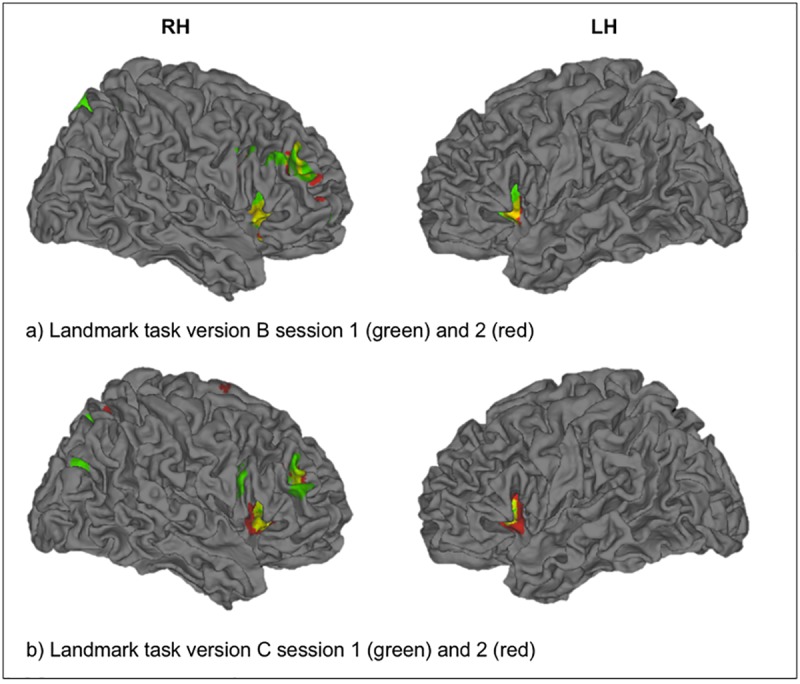
Group activation patterns evoked by the Landmark task version B and C.Activation of the first (green) and second session (red) are plotted together (p < 0.001 uncorrected, k = 20) for version B (top) and version C (bottom), respectively. Yellow colored regions indicate voxels that were active in both sessions. RH = right hemisphere, LH = left hemisphere.